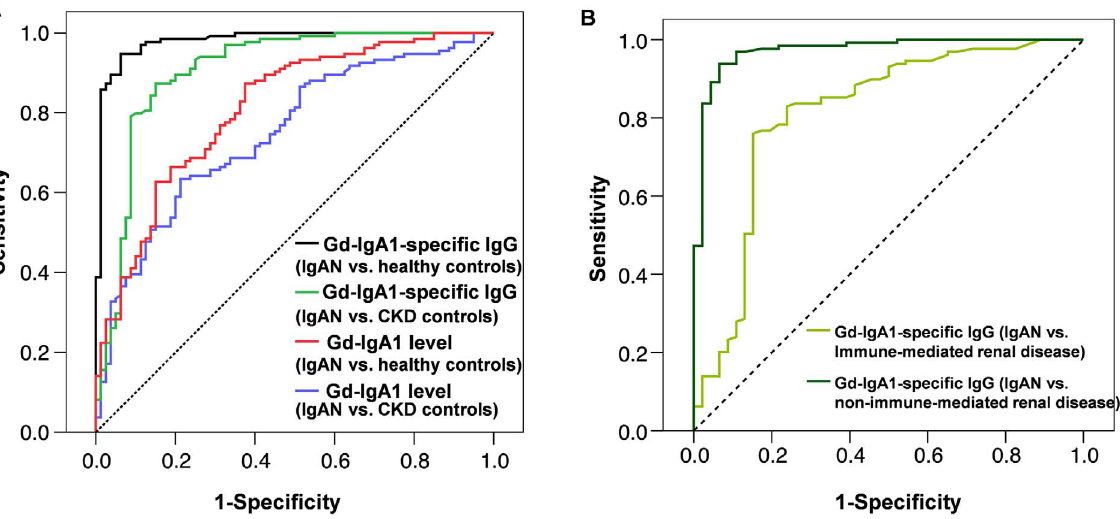
Figure 4. Receiver operating characteristic (ROC) curves. (A) Discrimination between IgAN versus healthy and CKD controls for serum Gd-IgA1 and Gd-IgA1-specific IgG levels; (B) Discrimination between IgAN versus CKD controls with immune-mediated renal disease and non-immune- mediated renal disease for serum Gd-IgA1-specific IgG levels.